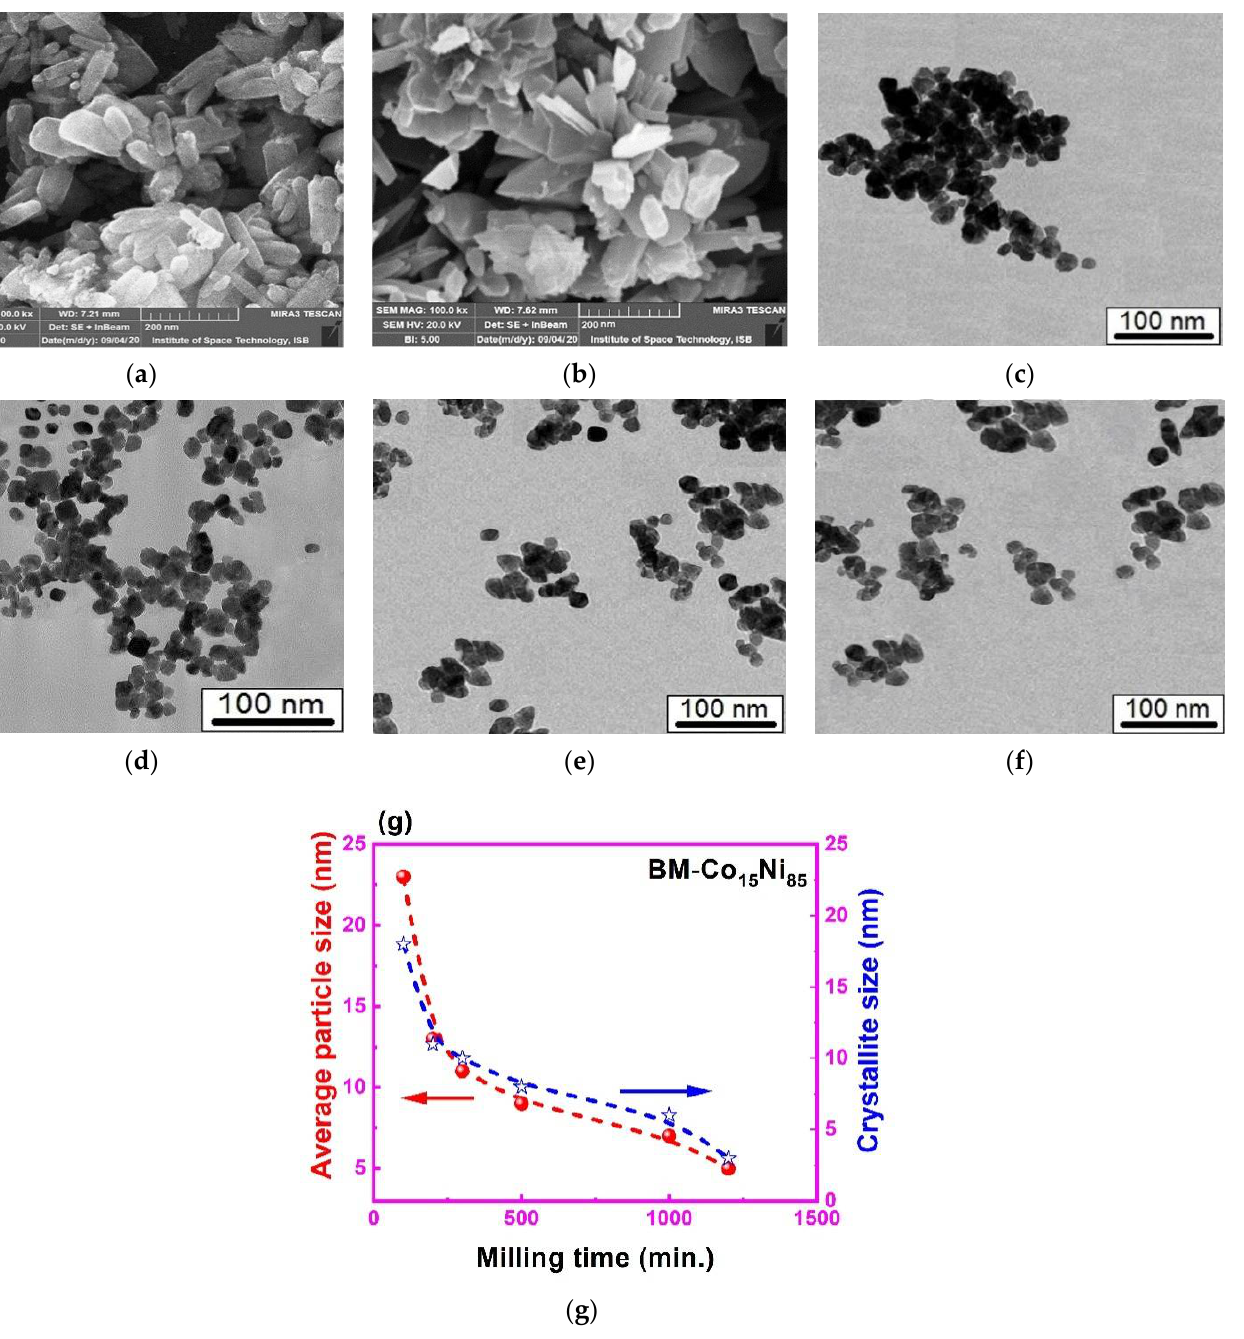
Figure 5. Field-emission scanning micrograph (FE-SEM) of ( a ) BM20-100, ( b ) BM50-100, transmission electron microscope (TEM) images of ( c ) BM80-300, ( d ) BM85-500, ( e ) BM85-1000, ( f ) BM85-1200 NPs and ( g ) The average particle size of milled NPs against the milling time.